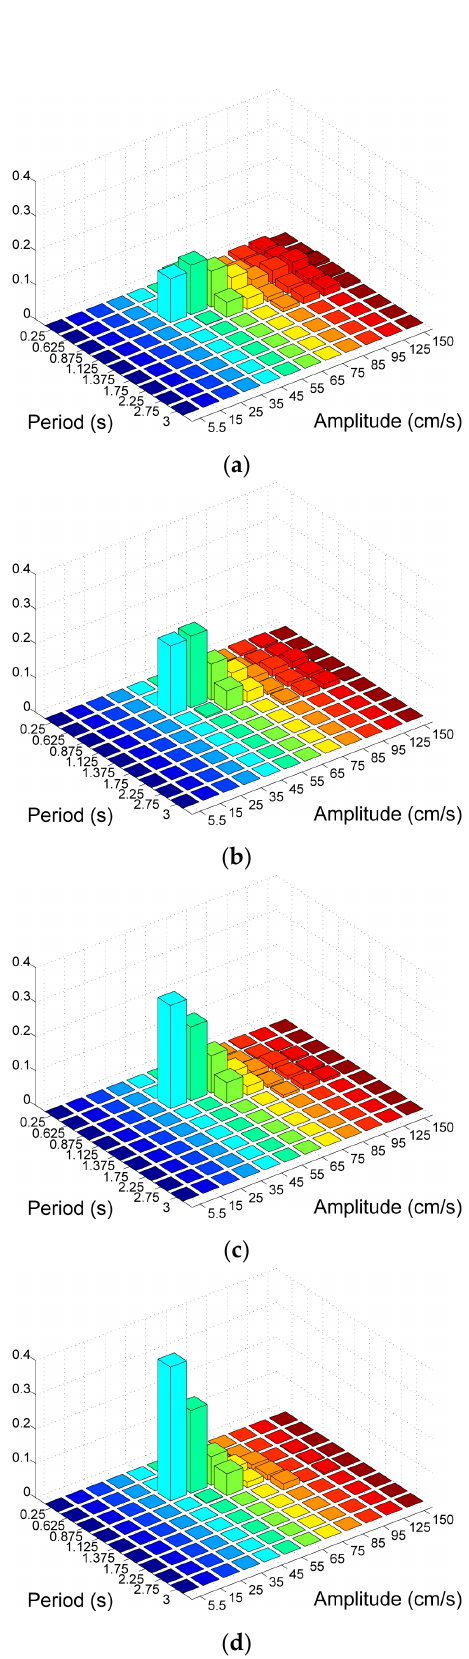
Figure 16. Period and amplitude deaggregation for a drift angle of 1% at a distance of ( a ) 6 km, ( b ) 11 km, ( c ) 16 km, and ( d ) 21 km from the centerline of the fault.